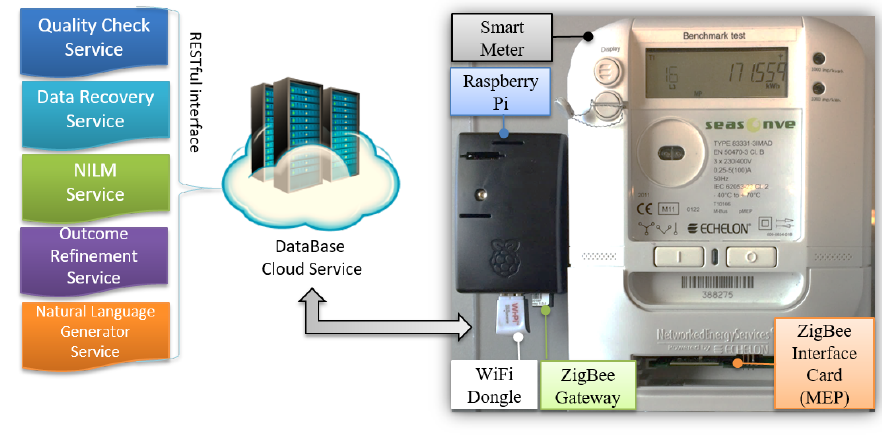
Figure 2. Framework structure.